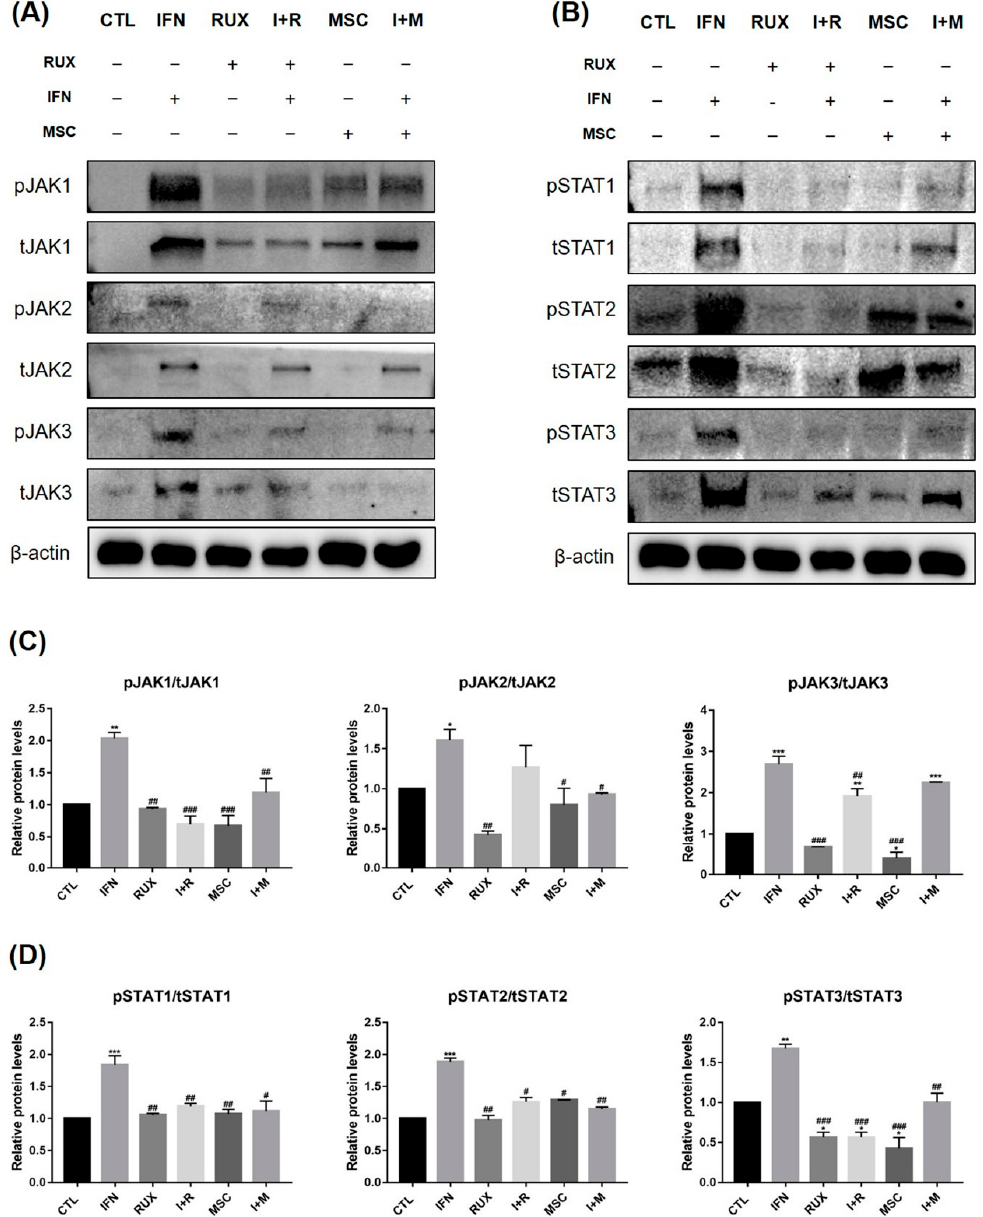
Figure 4. Changes in JAK/STAT pathway-related molecules in IFN-treated PBMCs after treatment with hMSCs or ruxolitinib. ( A , B ) Western blotting and ( C , D ) relative fold changes show that IFN treatment increase the levels of phosphorylated JAK1, JAK2, and JAK3 and STAT1, STAT2, and STAT3. Activated signaling of JAK/STAT pathway by IFN was remarkably suppressed by hMSC treatment at similar levels as those by ruxolitinib. The bands indicate serial protein expression levels up to 72 h after ruxolitinib treatments. The data represent the means ± SEM, n = 3, statistically significant at * p < 0.05, ** p < 0.01, and *** p < 0.001 compared to the control and # p < 0.05, ## p < 0.01, and ### p < 0.001 compared with the IFN- γ -treated group.